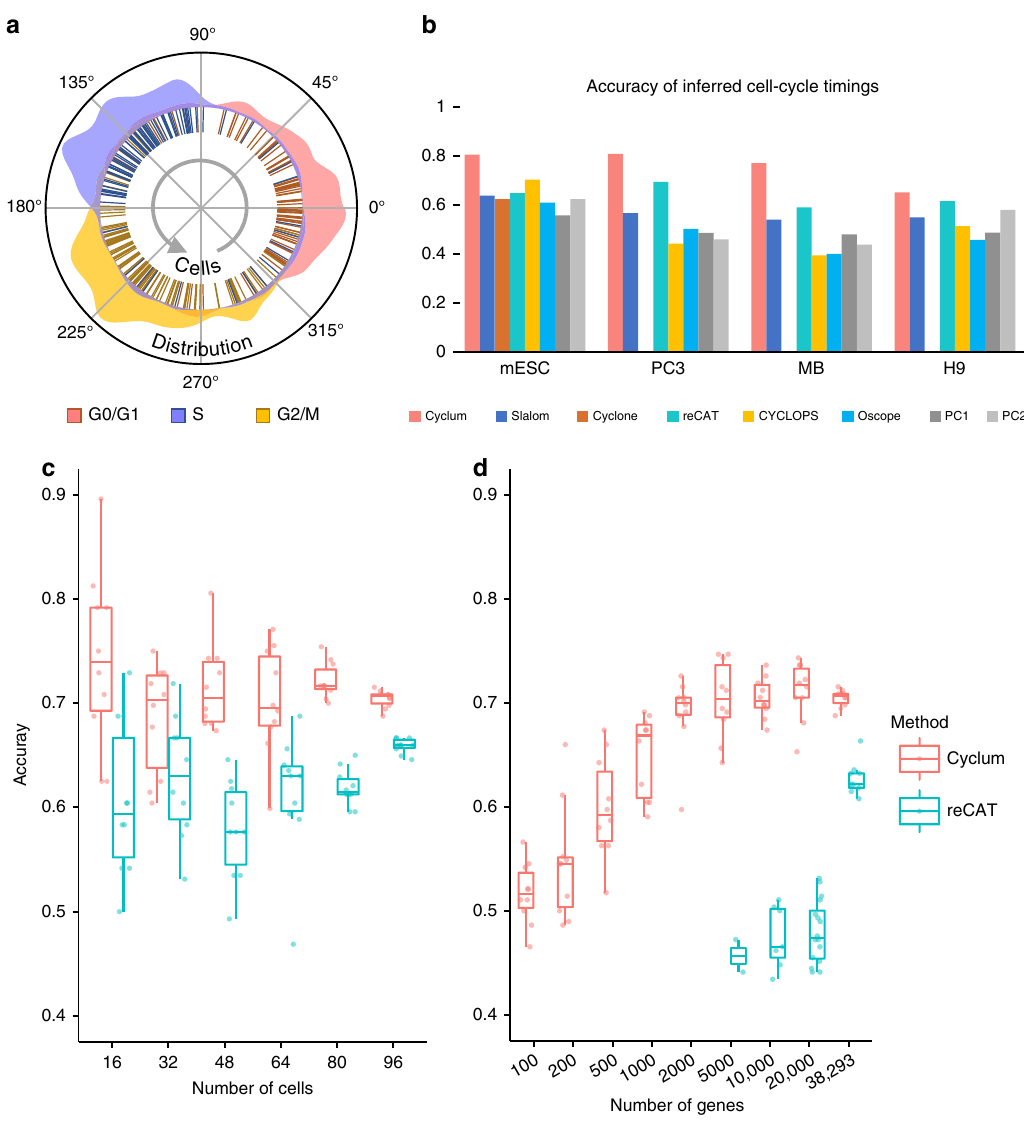
Fig. 2 Accuracy of cell-cycle inference. a Distribution of mESC cells over inferred cell-cycle pseudo-time. Curves outside are empirical distributions for cell-cycle stages and the lines inside represent individual cells. Colors correspond to ground-truth obtained experimentally by fl ow-sorting. b Cell cycle classi fi cation accuracy of Cyclum compared with Slalom, Cyclone, Cyclops, Oscope, reCAT, and principal component (PC) 1 and 2. c Cell-cycle classi fi cation accuracy ( Y -axis) of Cyclum (red) and reCAT (blue) over the number of cells ( X -axis) obtained from n = 10 randomly down-sampled datasets. d Cell-cycle classi fi cation accuracy ( Y -axis) over the numbers of genes ( X -axis, log-scale) obtained from n = 10 randomly down-sampled datasets for Cyclum, and n = 30 for reCAT. Only successful runs of reCAT were kept for plotting. For ( b ) and ( d ), the median (center lines), interquartile range (hinges), 1.5× interquartile range (whiskers), and corresponding data points (dots) are shown. Due to randomness in clustering, each method was evaluated fi ve times on each dataset and the best accuracy is recorded. In this context, n denotes sample size, not to be confused with number of cells in Methods. For all subpanels, source data are provided as a Source Data fi